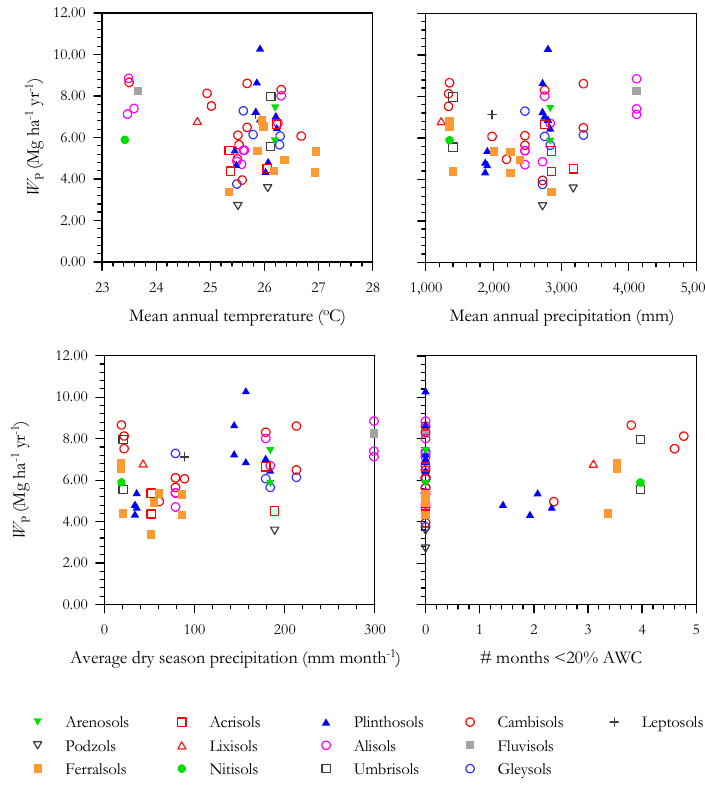
Fig. 5. Relationships between above-ground coarse wood production ( W P ) and climatic factors.